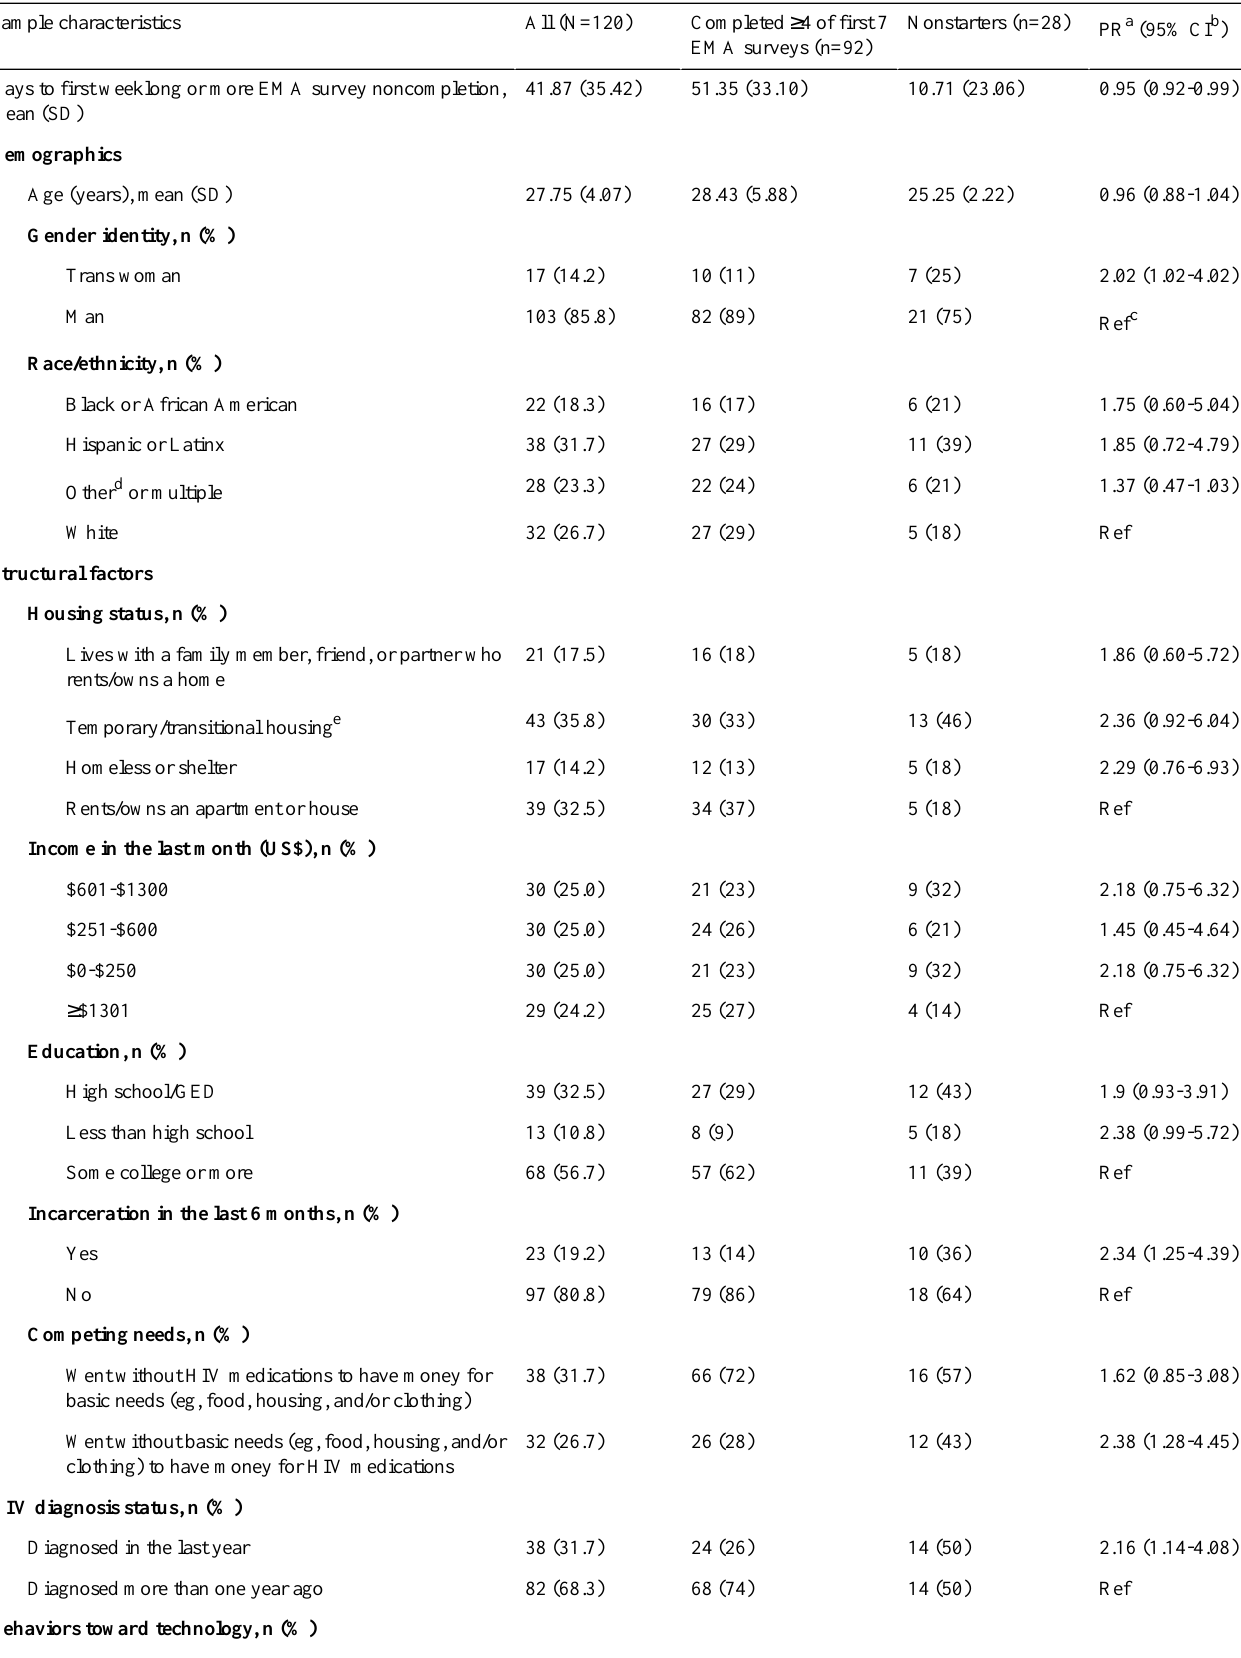
Table 1. Sample characteristics for all participants and by nonstarter status (ie, completed less than four of the first seven EMA surveys) from the 2017-2018 Health eNav study